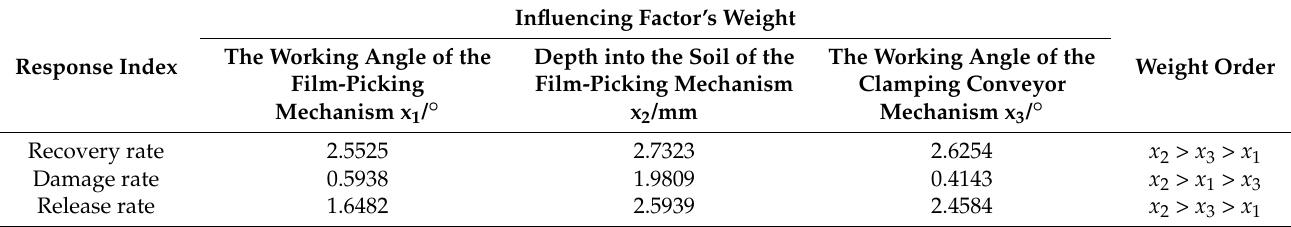
Table 6. The analysis of the influencing factors’